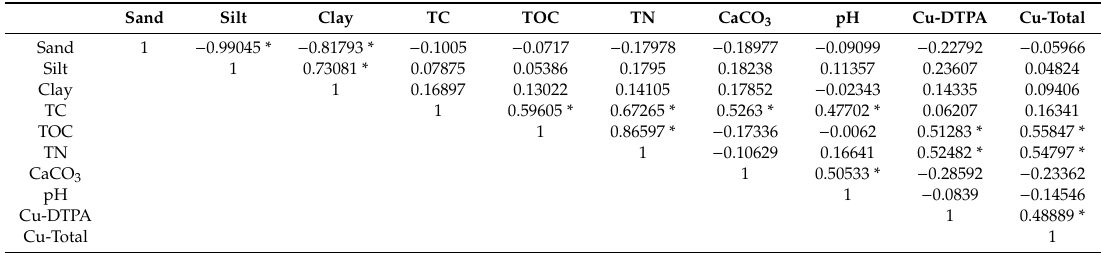
Table A1. Correlation matrix (Pearson) of the Aetoliko olive orchard soils data.